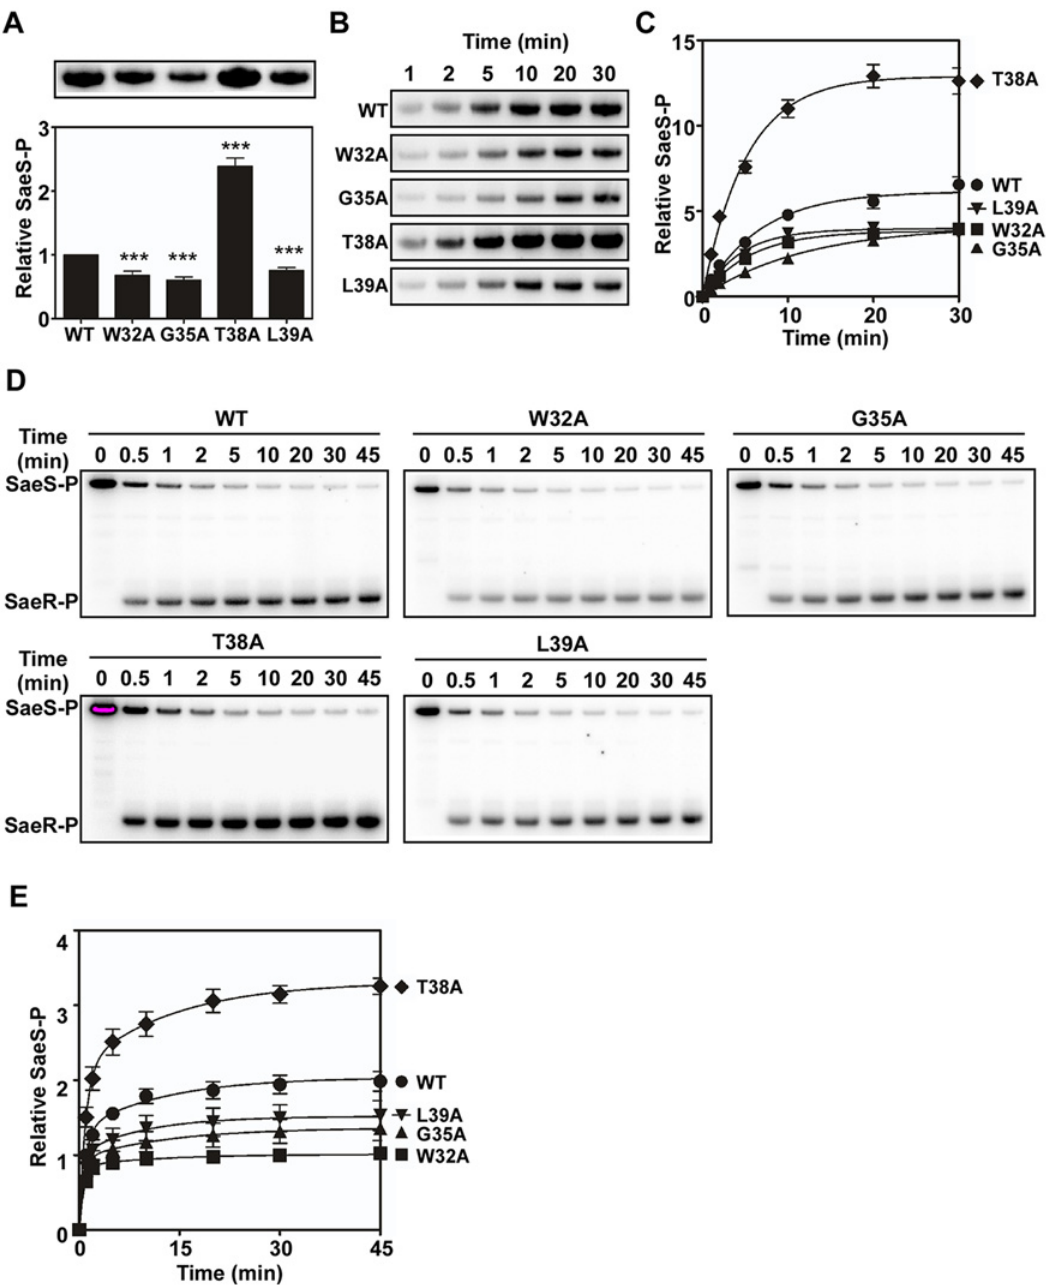
Fig 5. Alanine substitutions in the linker peptide alter the kinase and phosphotransferase activities of SaeS. (A) The autokinase activity of wild type (WT) and select linker peptide mutants of SaeS. The purified MBP-SaeS proteins (5 μ M) were incubated with [ γ - 32 P] ATP at RT for 20 min. The autoradiograph of the phosphorylated MBP-SaeS (upper panel) is shown with its quantification results in a bar graph (lower panel). (B) Assessment of the autokinase activity of wild type (WT) and select linker peptide mutants for 30 min. The wild-type or the linker peptide mutant MBP-SaeS proteins (5 μ M) were mixed with [ γ - 32 P] ATP and, at the indicated times, the level of phosphorylated MBP-SaeS was analyzed by phosphor imager analysis. (C) Quantitation of the autophosphorylation assays shown in (B). The plot depicts the levels of MBP-SaeS-P relative to the wild-type MBP-SaeS-P at time 1 min as a function of time. (D) Phosphotransferase activity of the wild type (WT) and select linker peptide mutants of SaeS. Phosphorylated MBP-SaeS (5 μ M) was mixed with SaeR (10 μ M). At the times indicated, the reaction was stopped and the phosphorylated proteins were analyzed by SDS-PAGE and phosphor imager analysis. (E) Quantification of the phosphotransfer assays shown in (D). Each datum on the plot depicts the level of SaeR-P relative to that of the wild-type SaeS at the initial time (1 min). All data correspond to the mean values of three independent experiments, and error bars show standard deviation. For statistical analyses, unpaired two-tailed student ’ s t-test was used. *** , p < 0.001